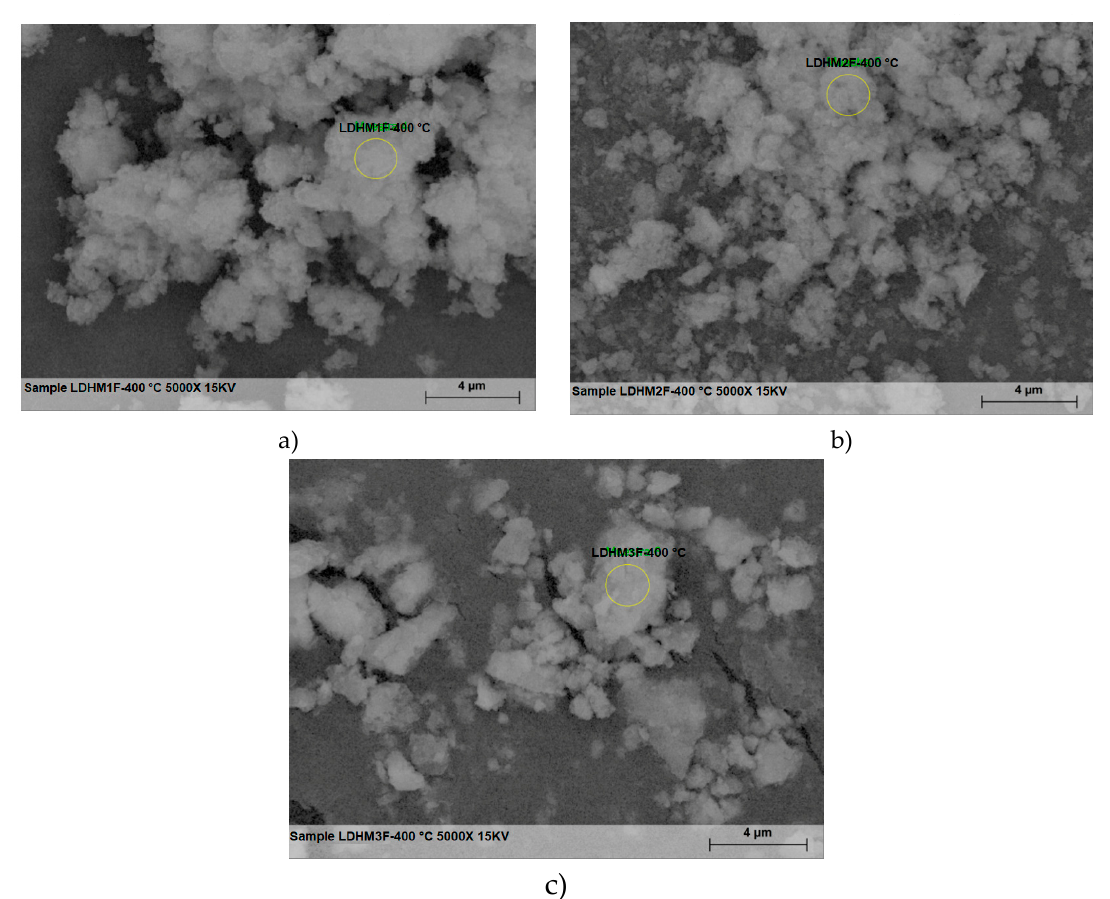
Figure 5. Scanning micrograph of activated layered double hydroxides at 5000x. a ) LDHM1F-400 °C, b ) LDHM2F-400 °C, c ) LDHM3F-400 °C.